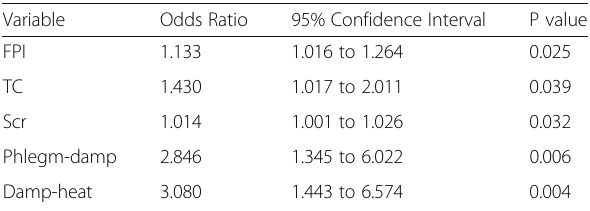
Table 3 Multiple logistic regression analysis of variables to predict diabetes Variable Odds